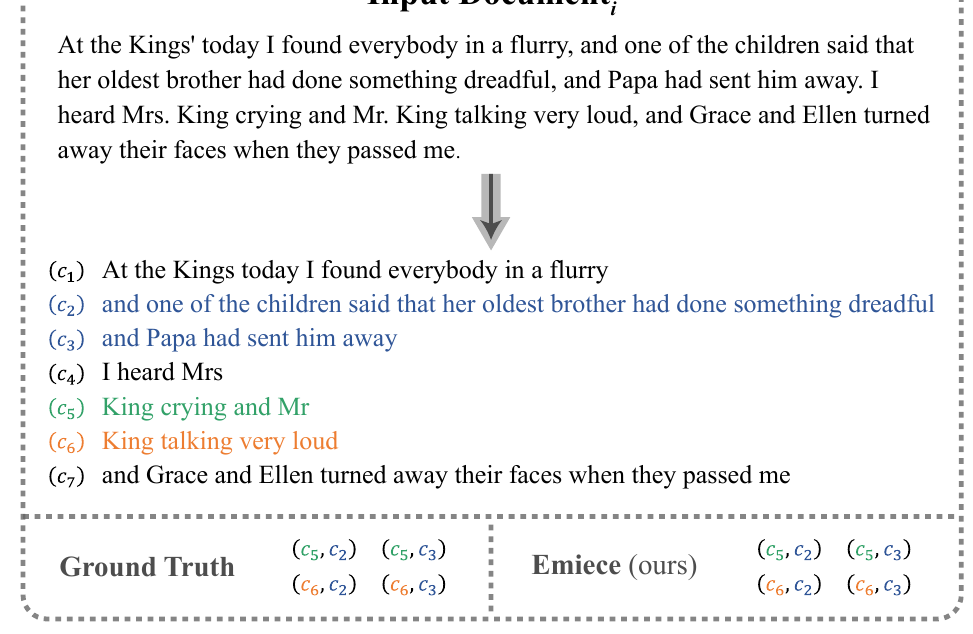
Figure 5. A case study of our method. Our method also works well in extracting emotion–cause pairs when the input text contains multiple emotions and multiple causes that match each other.